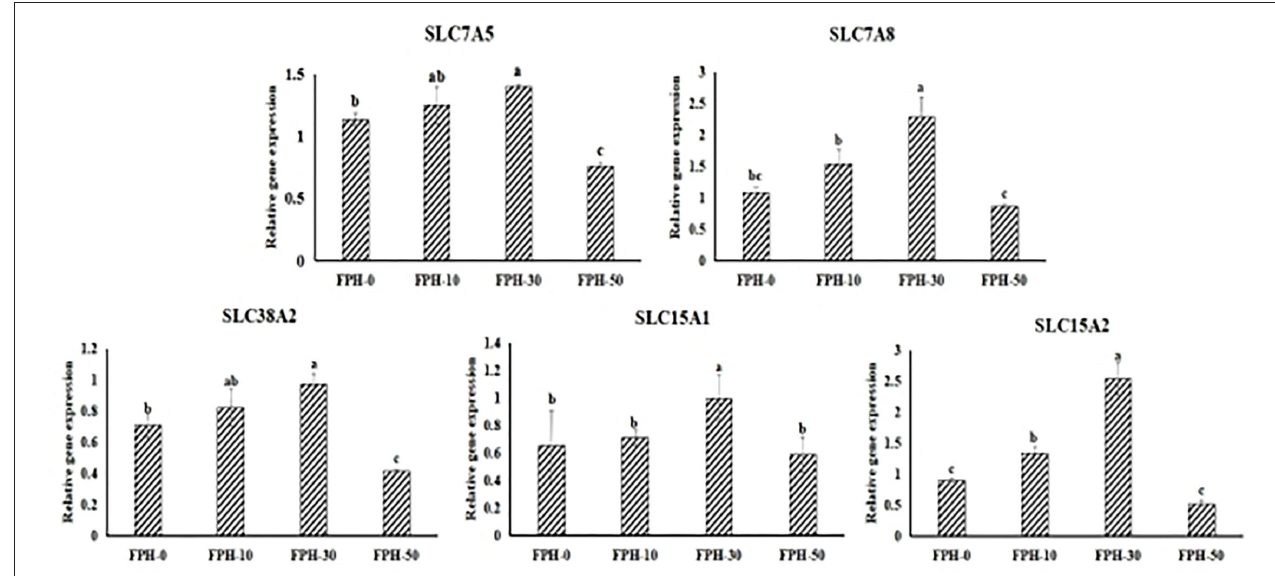
FIGURE 3 | Relative expression of relative peptide and AA transporters related genes in the intestine of largemouth bass ( Micropterus salmoides ) fed the diets containing different supplementation levels of fish protein hydrolysate (FPH).